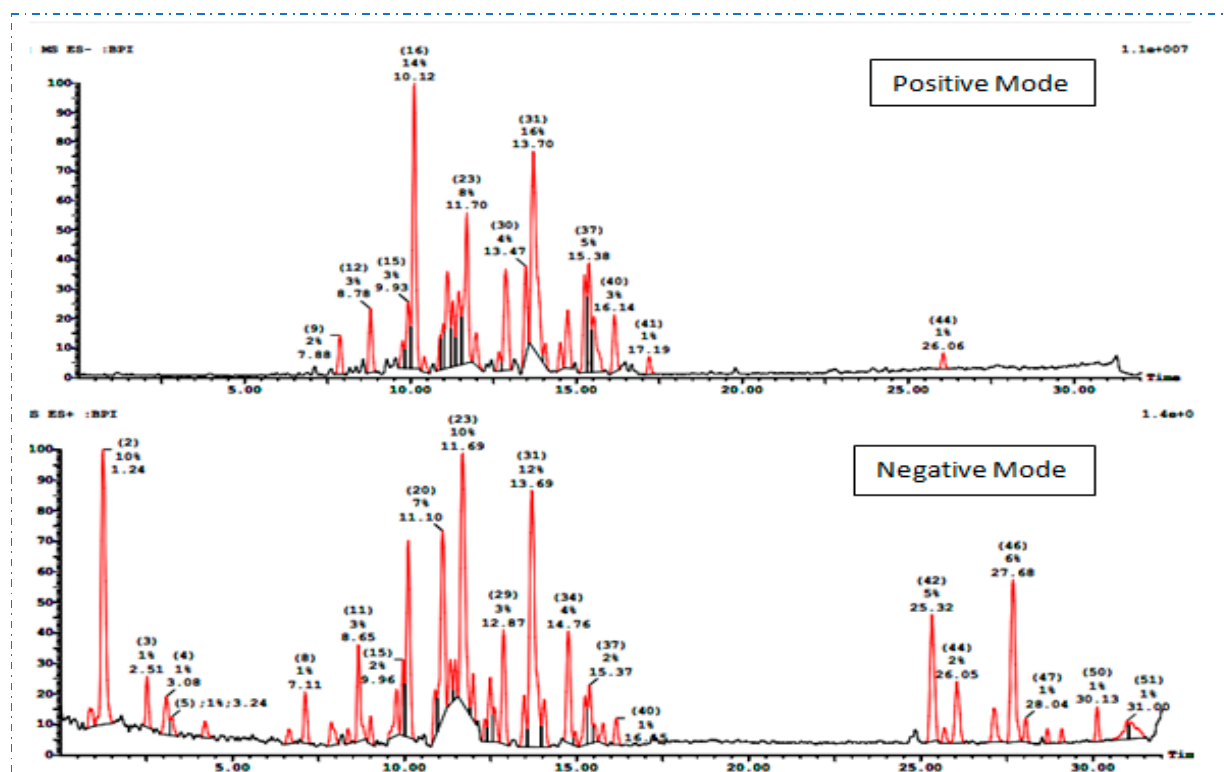
Figure 2. Chromatograms of UPLC-ESI-MS/MS in positive and negative modes of the dichloromethane fraction of S. hispanica L. aerial parts. Table 2. Tentatively identified compounds in the dichloromethane fraction of S. hispanica L. aerial parts.